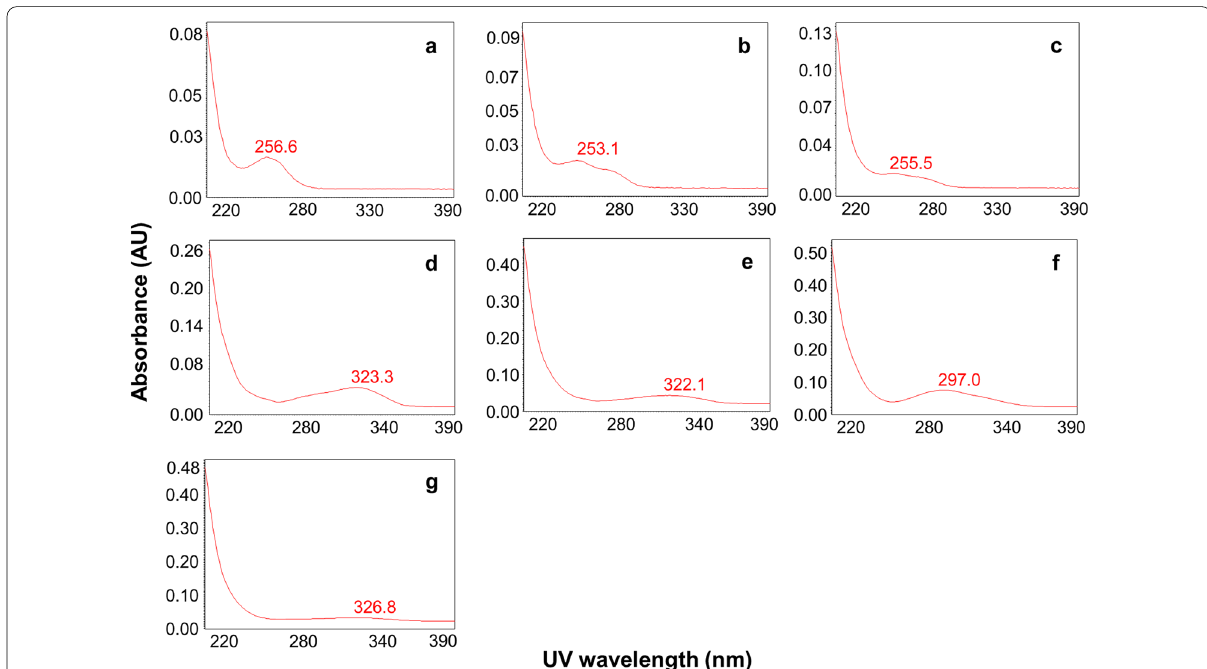
Fig. 1 UV spectra of 7 common peaks ( a – g ) for specificity. Peaks ( a ), ( b ), and ( c ) were detected specific wavelengths at 256.6, 253.1, and 255.5 nm. Peaks ( d ), ( e ), and ( g ) were detected specific wavelengths at 323.3, 322.1, and 326.8 nm, and f at 297.0